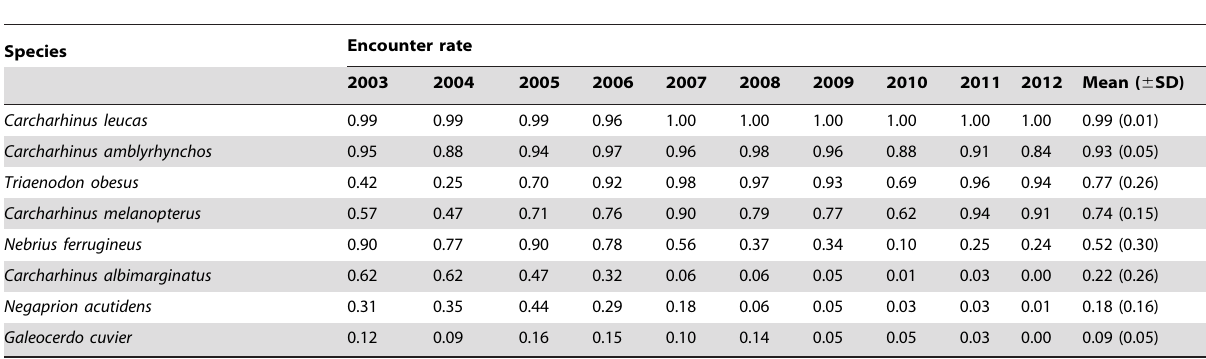
Table 1. Encounter rates of each shark species at the Shark Reef Marine Reserve.